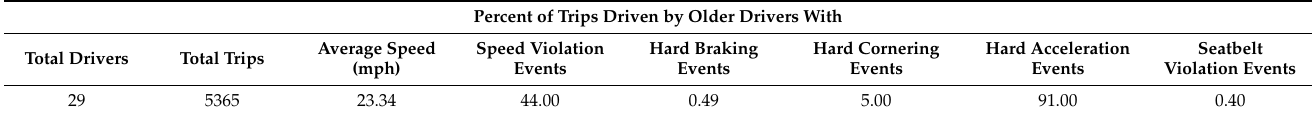
Table 4. Summary of the risky driving behavior events recorded from the OBDII device across all trips taken by older drivers during the three-month period.